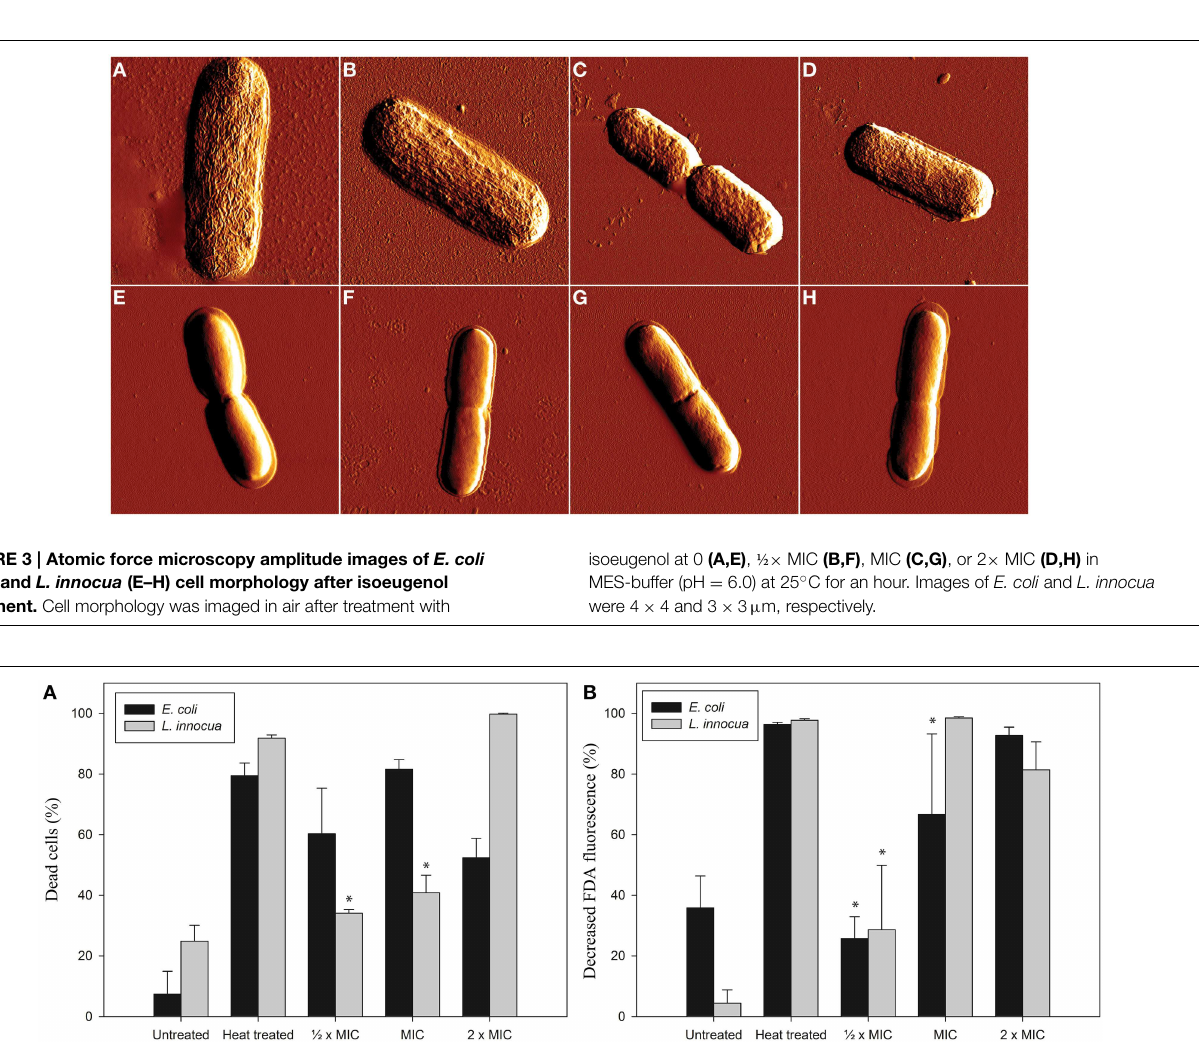
FIGURE 4 | Isoeugenol induce changes in cytoplasmic membrane integrity (A) and esterase activity (B) of E. coli (black bars) and L. innocua (gray bars) cells. Living and heat treated cells suspended in MES-buffer (pH 6.0) were treated with or without isoeugenol at different concentrations for an hour at 25 ◦ C, then harvested and resuspended in MES-buffer together with FDA,